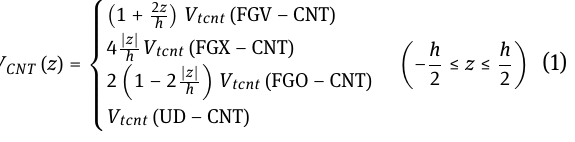
length R in radial direction ( R = R 1 - R 0 ) and sector angle θ in